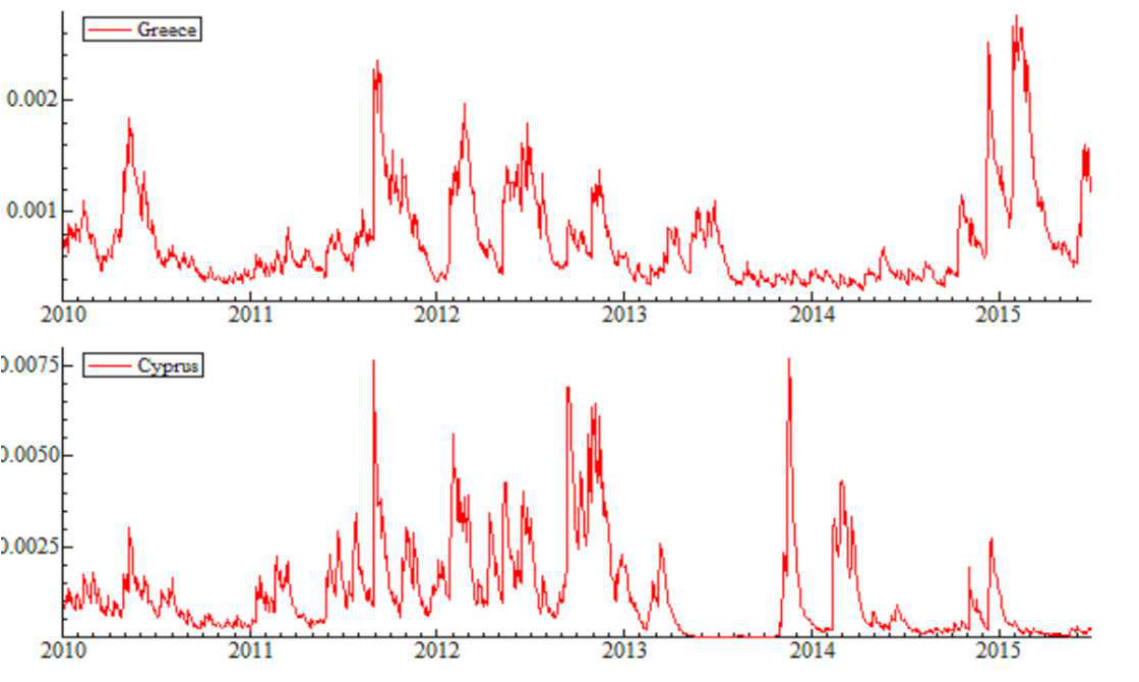
Figure 4. Univariate conditional variances (EDC